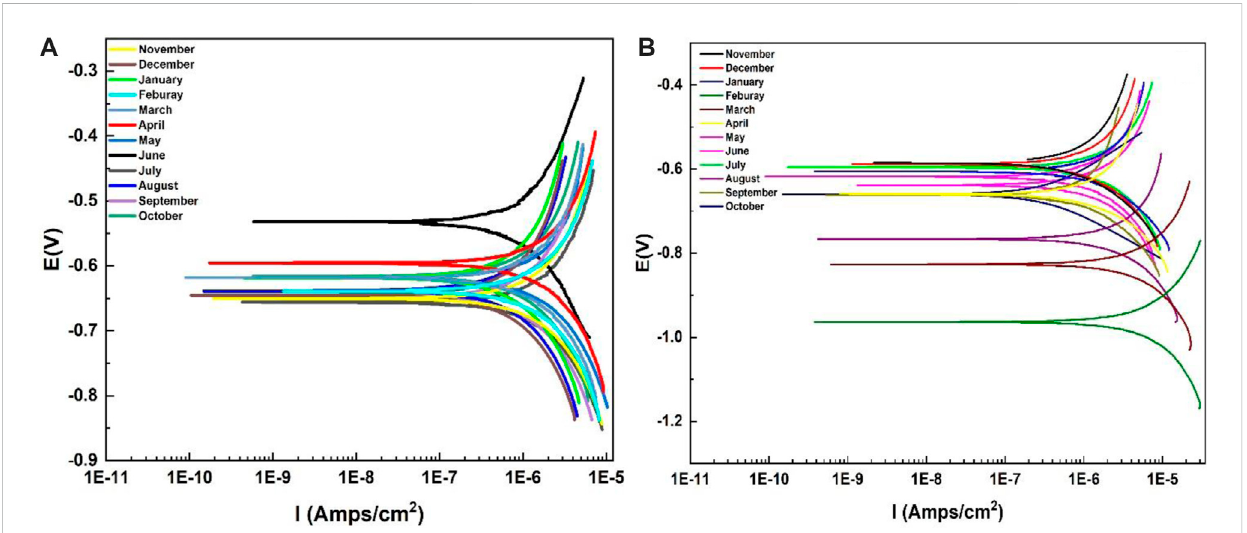
FIGURE 6 Polarization curves of epoxy in the alkaline solution of NaOH with pH 11 for 1-year (A) ZP pigments mod. Epoxy; (B) Neat epoxy.